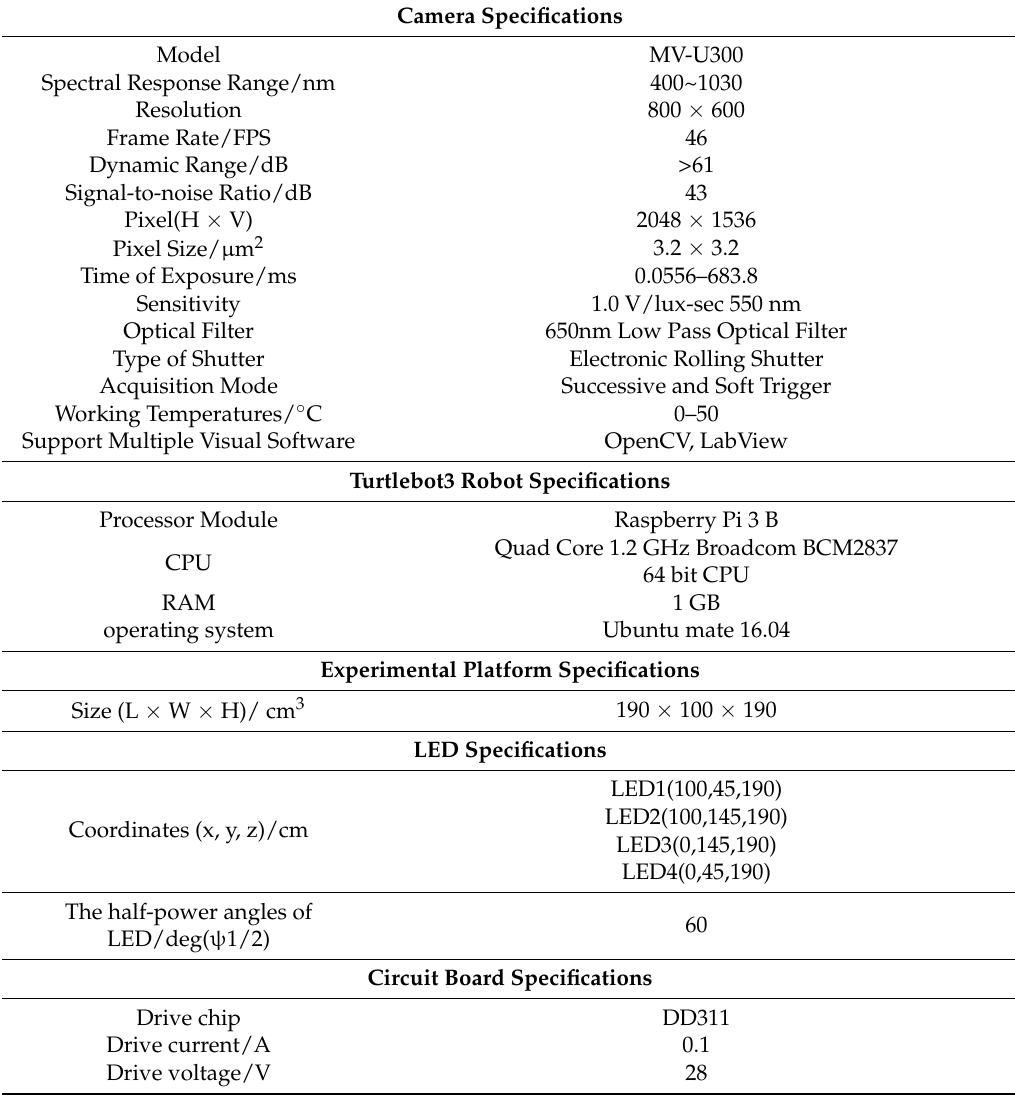
Table 1. Parameters of experimental facilities and